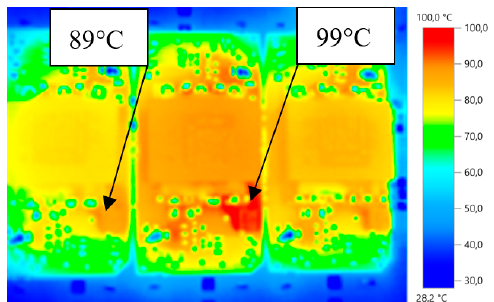
Figure 15. Thermal image of ACA arrangement for the following operating point of Vin = 45 V; Vout = 13.7 V; Pout = 90 W.